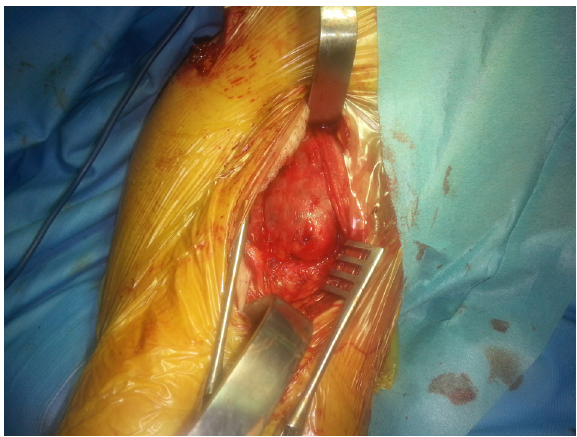
Figure 4: Aortic aneurysm.